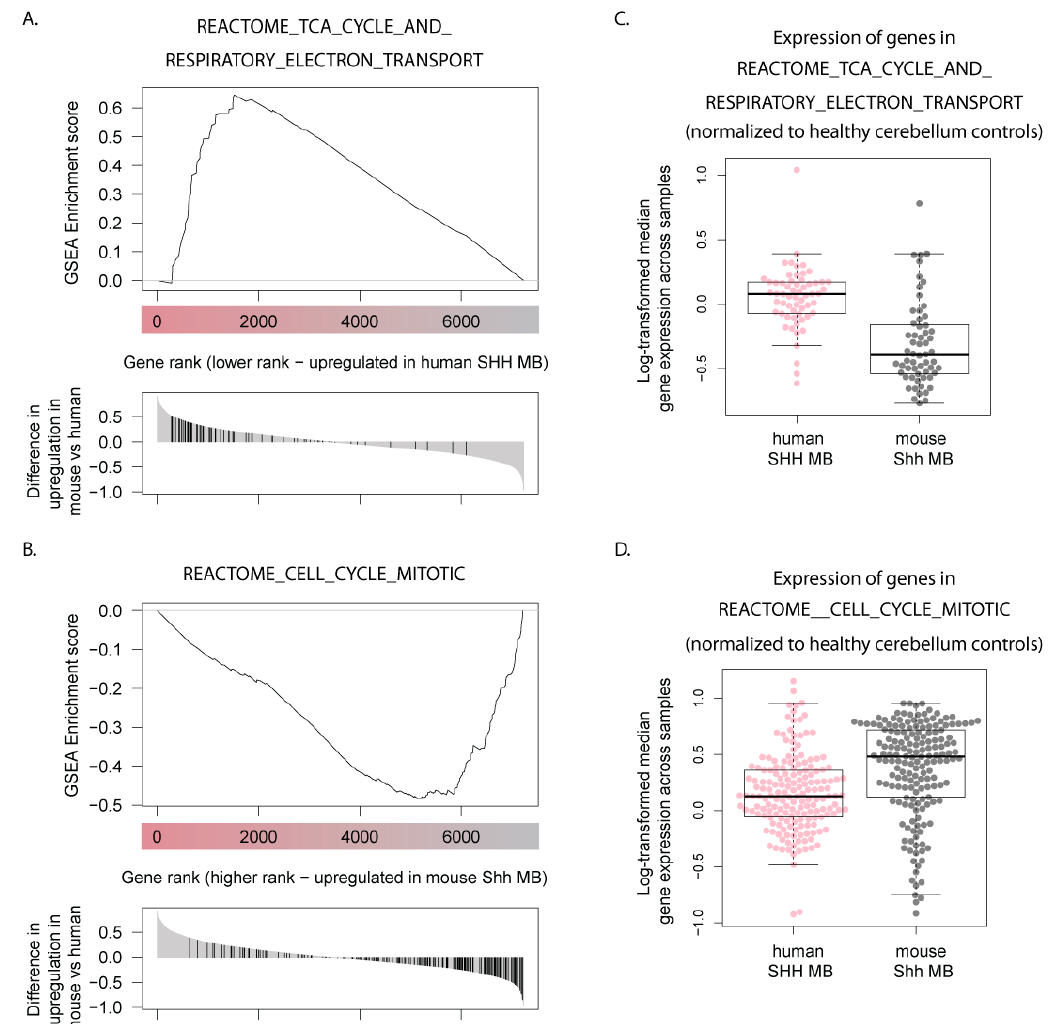
Figure 5. ( A , B ) Genes specifically upregulated in human SHH-MB ( A ) and mouse Shh-MB ( B ) are enriched for genes associated with mitochondrial function and proliferation, respectively. Gene set enrichment analysis (GSEA preranked) was performed on a list of genes ordered according to differences between their overexpression values in human vs. mouse Shh-MB. Example GSEA plots from among the most highly significant categories are presented. See also Tables 2 and 3. ( C , D ) Median log-transformed expression of genes from the two GSEA gene sets shown in A. and B. in human and mouse SHH-MB compared to their respective healthy cerebellum controls. Cerebellum expression values equal 0 in both cases. Each data point represents a different gene from the gene set. See also Figure S3.